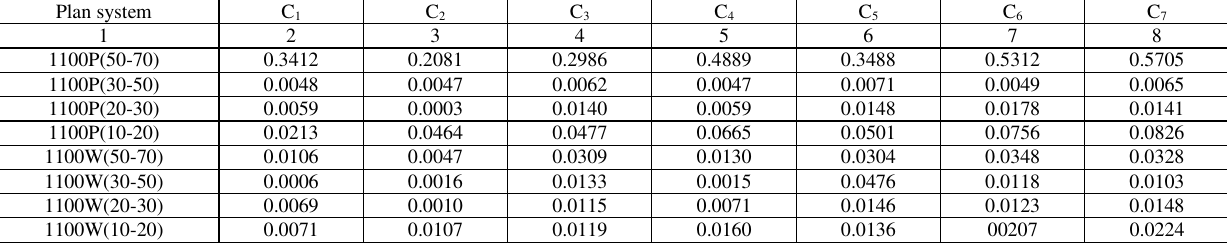
Table 3. Numerical values of the diagnostic variables for NO x concentration